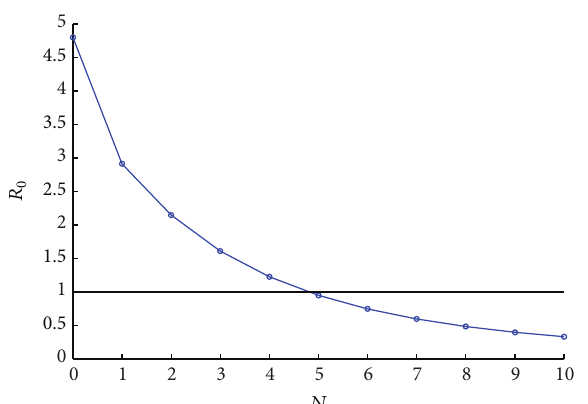
Figure 3: Plot of the basic reproduction number 𝑅 0 as a function of the delay 𝑁 . Here, 𝜆 = 10 , 𝑑 = 0.02 , 𝛽 = 0.000024 , 𝑚 = 0.5 , 𝑎 = 0.5 , 𝑘 = 600 , 𝜇 = 3 , and ℎ = 0.1